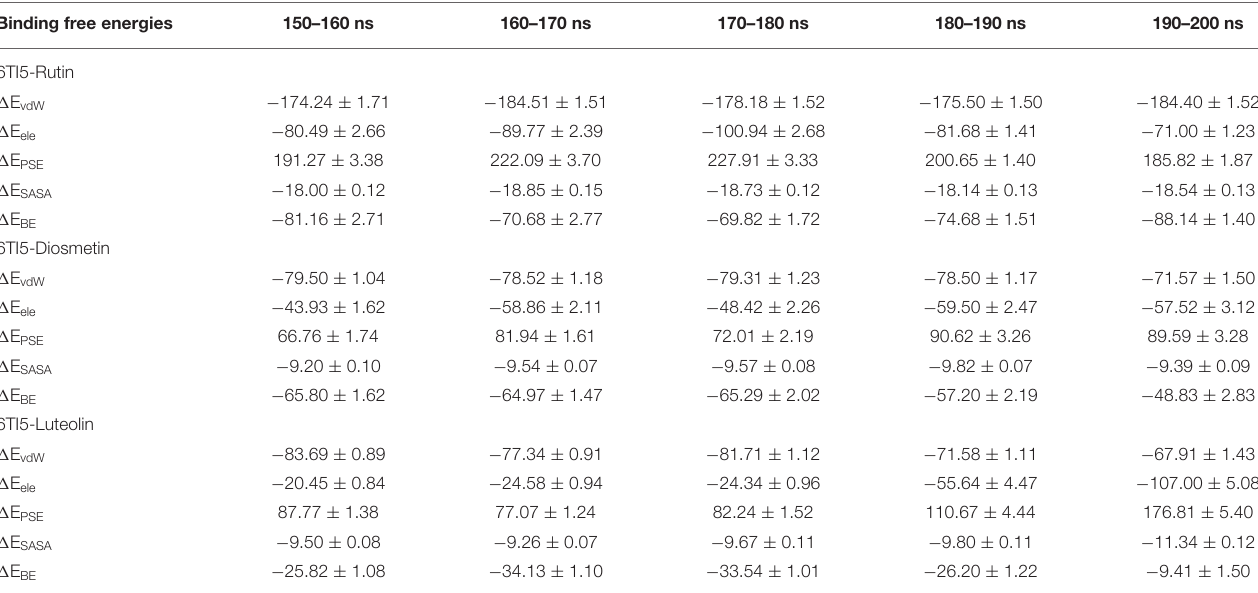
TABLE 6 | Binding free energies (kJ/mol) determined by MM-PBSA calculations of the last 50 ns of trajectories of 6TI5 in complex Diosmetin, Luteolin, and Rutin. Binding free